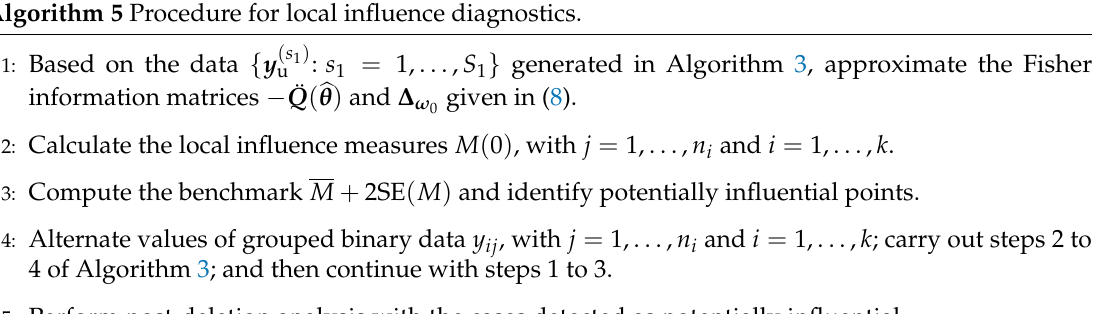
Algorithm 5 Procedure for local influence diagnostics.